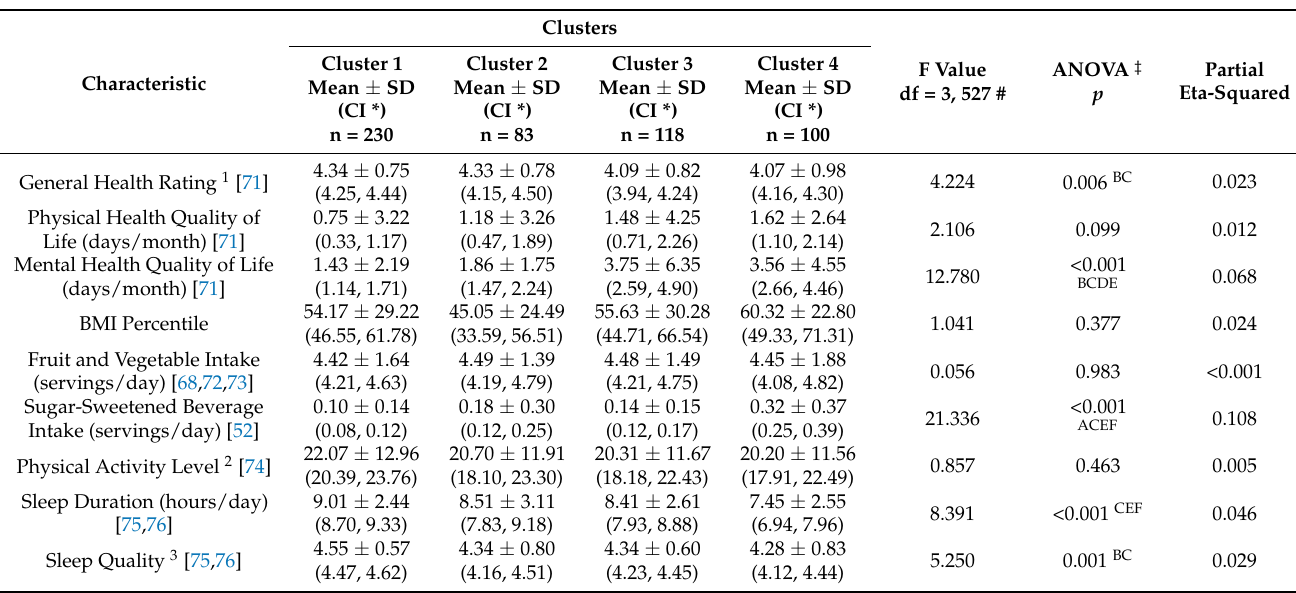
Table 5. Child Health and Weight-Related Behaviors by Maternal Mental Health Status Cluster (N =